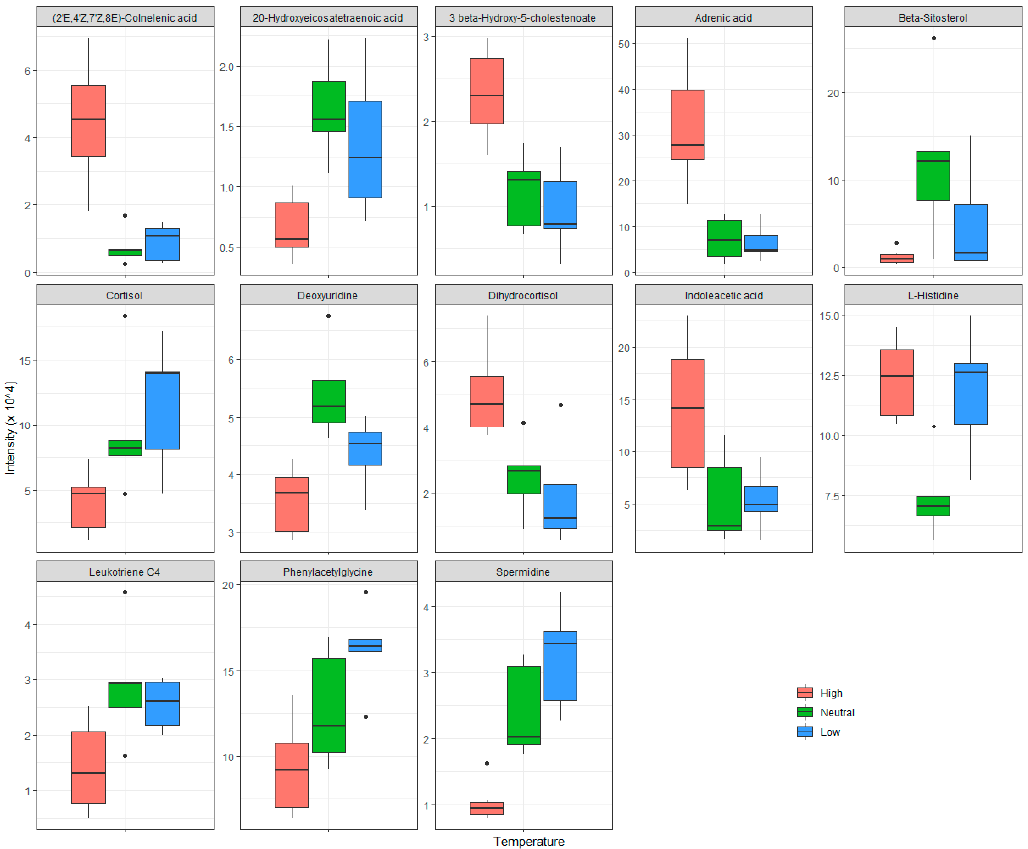
Figure 2. Identified compounds through metabolomics analysis with different intensities in plasma samples from pigs at 25 kg kept at different ambient temperatures. No statistical analysis was conducted in this figure. Low: 18 °C; Neutral: 23 °C; High: 32 °C.